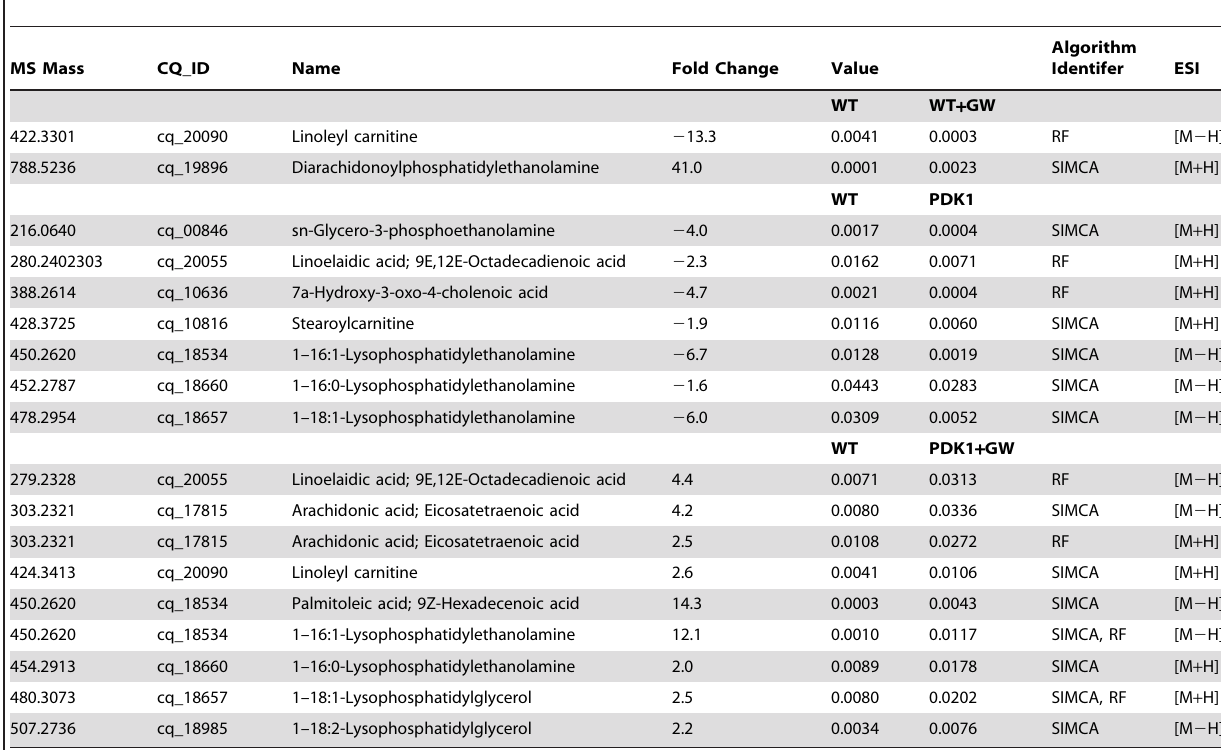
Table 3. Metabolomic profile in MMTV-PDK1 and GW501516-treated animals.